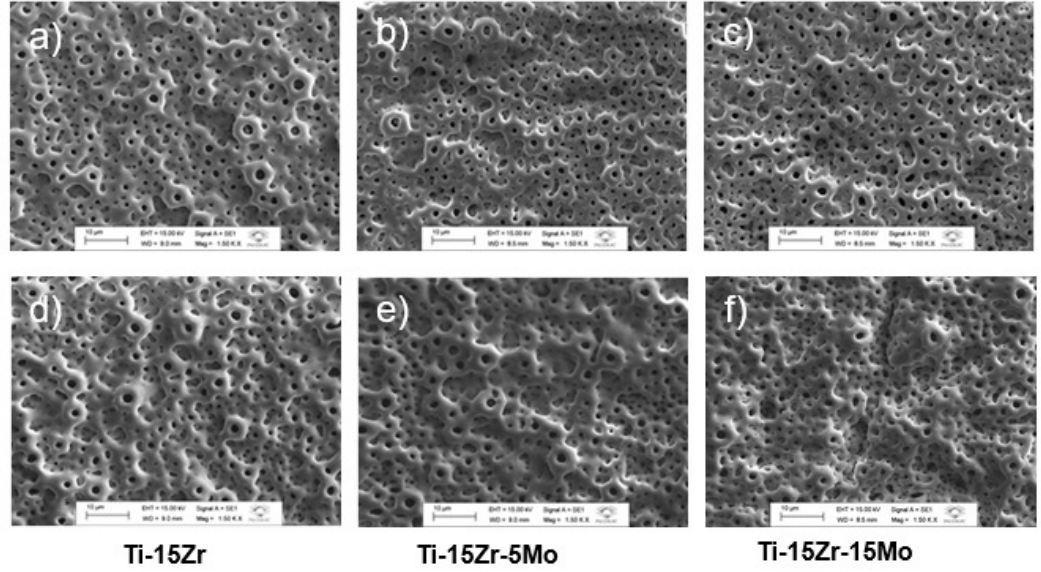
Figure 4: Morphology of the oxide layers obtained by MAO in the samples: as-cast (a, b and c) and heat-treated (c, d and f) conditions.